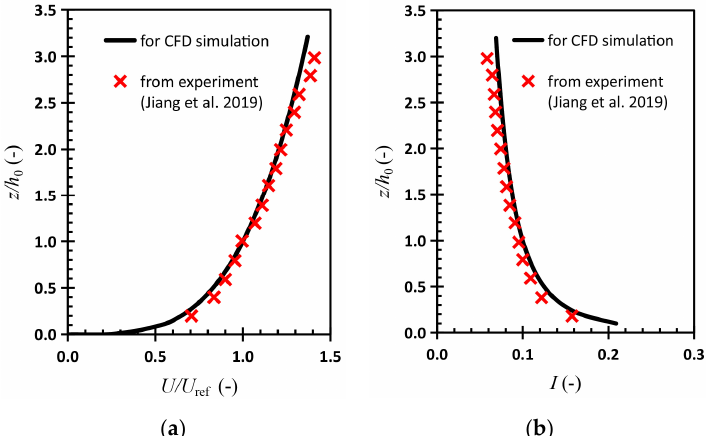
Figure 3. Measurement lines on the central plane of the studied building for ( a ) velocity U ; and ( b ) wind pressure coefficient C p . Figure 4. Wind characteristics of approaching flow for computational fluid dynamics CFD simulation: ( a ) velocity U ; and ( b ) turbulent intensity I distributions.